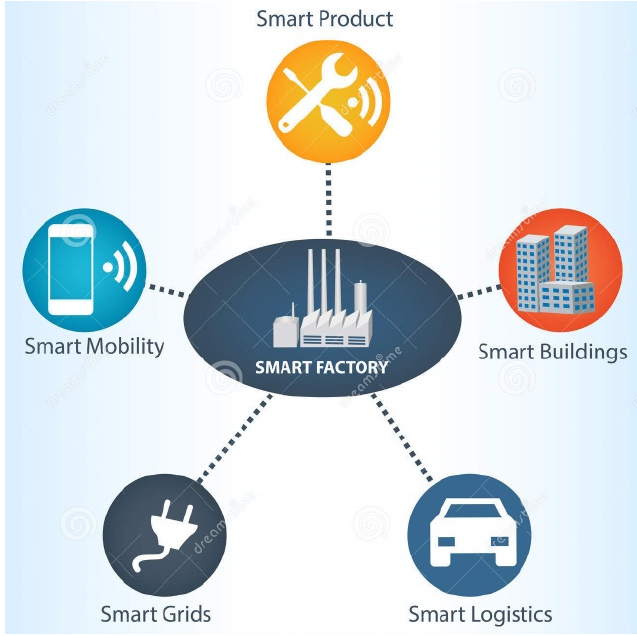
Figure 3. Industry 4.0 and smart factories P.Odoroaga